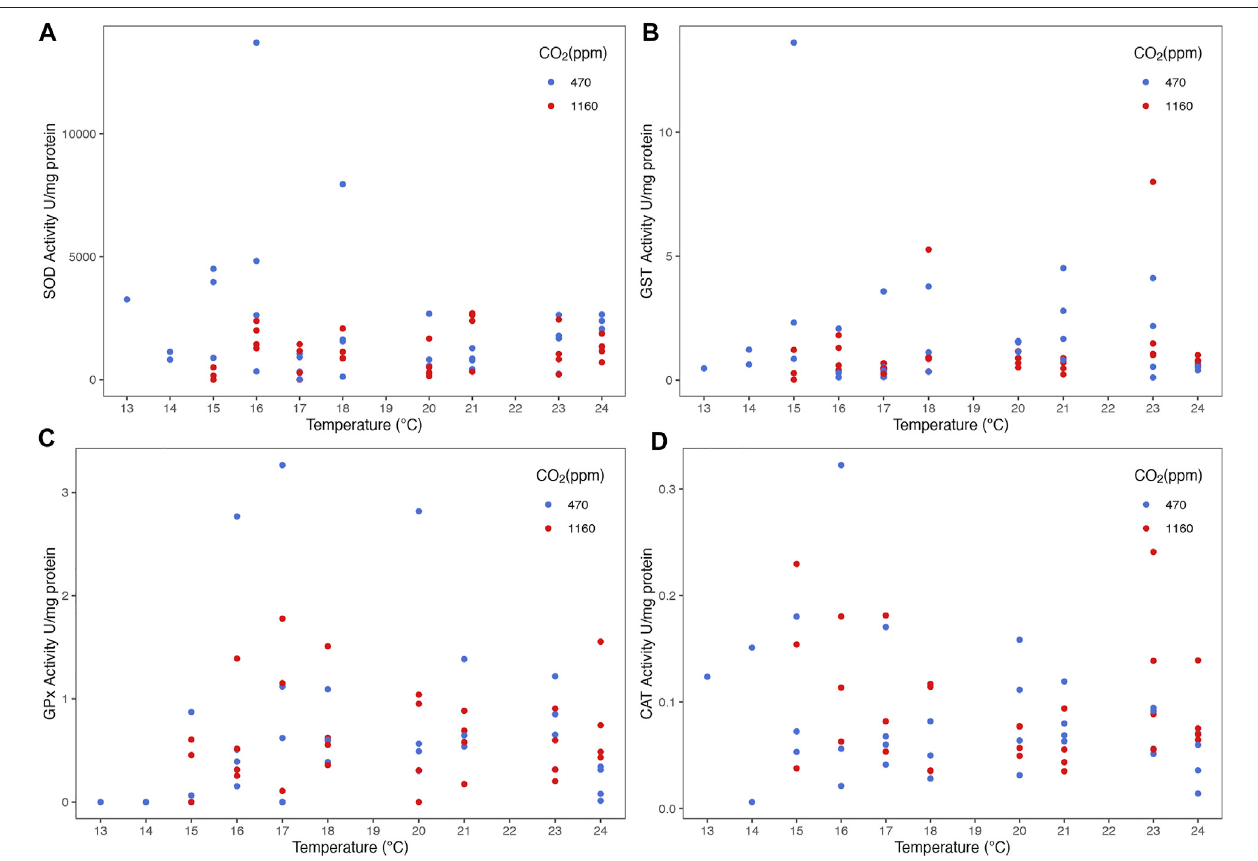
FIGURE 7 | Effect of temperature and ocean acidi fi cation on antioxidant enzyme activities of stage III Homarus gammarus larvae. There was no effect of experimental conditions (temperature gradient and p CO 2 levels) on antioxidant response: (A) SOD, (B) GST, (C) GPx and (D) CAT. Each point represents the average response quanti fi ed in larvae originated from the same female. Curves correspond to smooths fi tted with the best (general additive) model, obtained after backwards model selection.